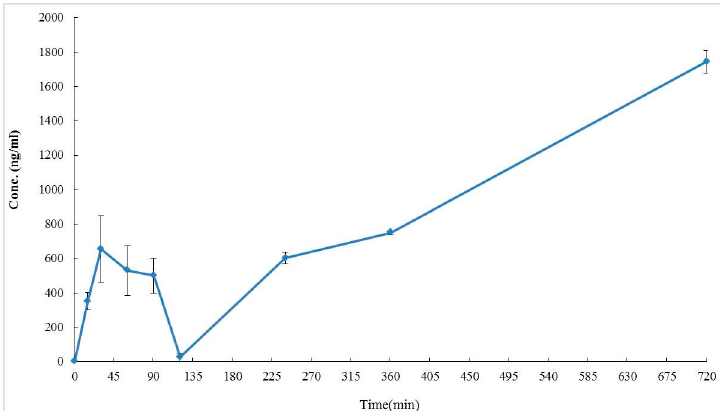
Figure 6. Concentration-time profile of 1 in rat serum after 1 oral administration (100 mg/kg). The data represented mean ± S.D., n = 3.